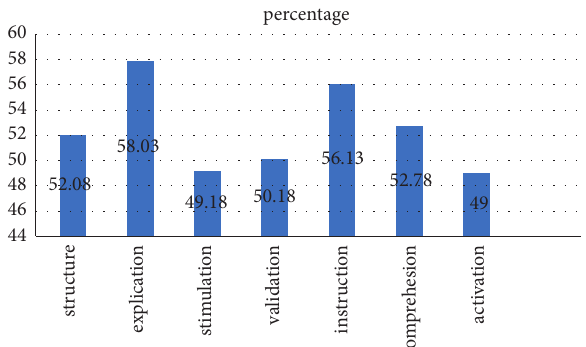
Figure 1: Percentage of students’ satisfaction using the seven ISQ